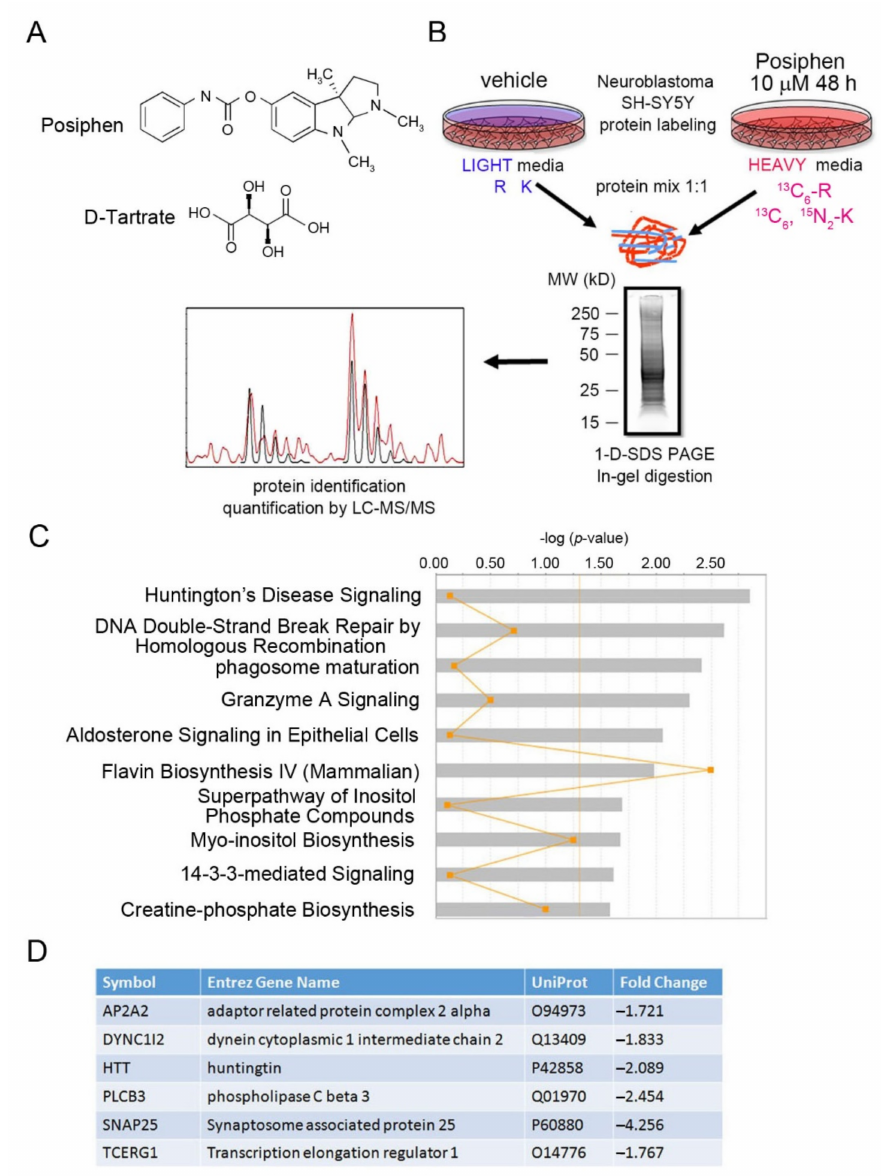
Figure 1. Main canonical pathways affected by Posiphen using the stable isotope labeling with amino acids in cell culture (SILAC) method for SH-SY5Y cells. ( A ) Chemical structure of Posiphen as the Tartrate salt. ( B ) Cell lysate from the two treatment conditions (with or without Posiphen 10 µ M) were mixed in equal quantities and loaded on a gel. The obtained gel stained with SYPRO ® is reported. Gel was cut and subjected to tryptic digestion prior to analysis by mass-spectrometry in Nano LC-MS/MS Orbitrap Q-Exactive. Raw data were subjected to bioinformatics analysis to identify and subsequently filter proteins with significant changes in expression levels. Ingenuity Pathway Analysis (IPA) identified cluster pathways affected by the treatment. MW: molecular weight; SDS-PAGE: sodium dodecyl sulfate-polyacrylamide gel electrophoresis; LC-M/MS: liquid chromatography tandem mass spectrometry. ( C ) Differentially expressed proteins were clustered by IPA. The 10 most statistically significantly affected ( p < 0.05) canonical pathways are shown. The significance threshold value (-log [ p -value]), set at 1.3, is highlighted in orange. Orange pints are the ratio of the number of genes that meet the cut-off criteria/the number of genes that make up that pathway. ( D ) The most downregulated proteins ( ≤ 1.7) in the Huntington’s pathway are